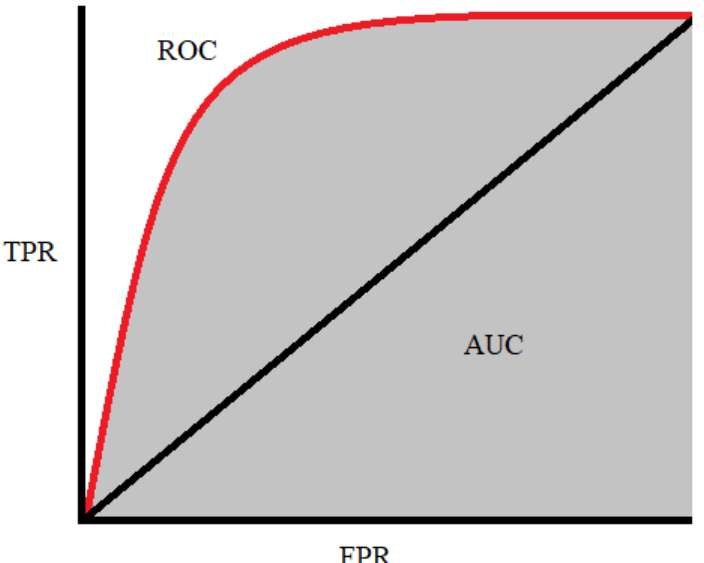
Figure 2. The receiver operating characteristic curve is plotted with the true positive rate (TPR) against the false positive rate (FPR), where FPR is on the x-axis and TPR is on the y-axis [44].